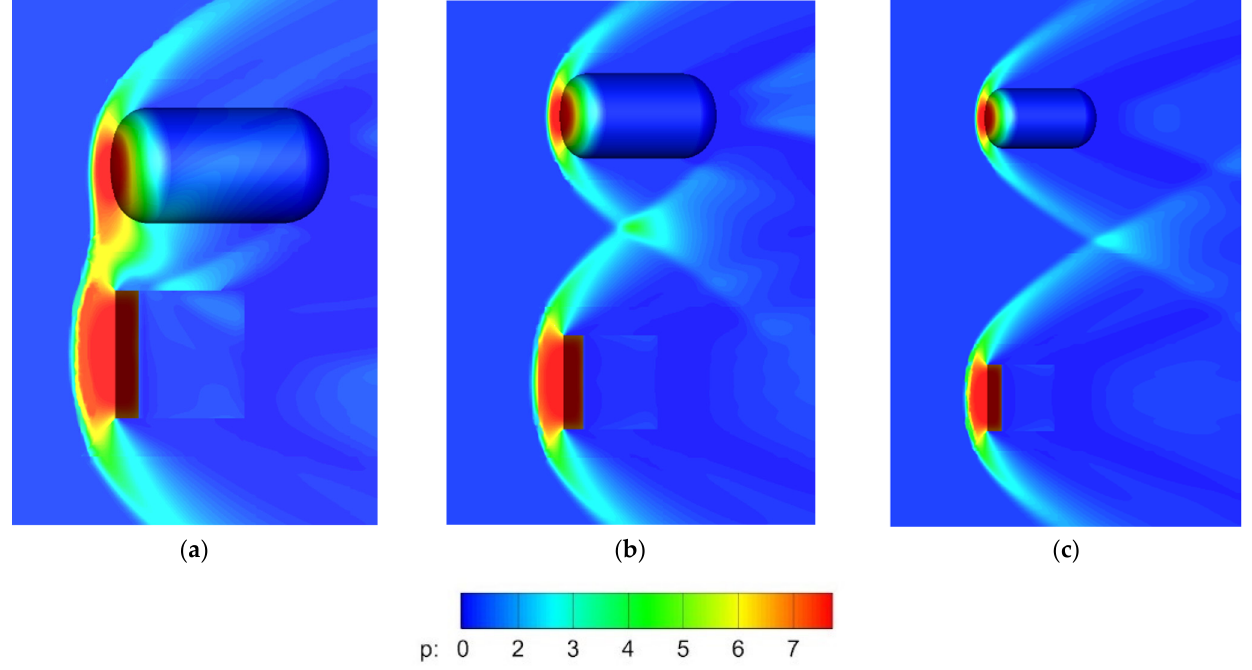
Figure 13. Dimensionless pressure contours of flow around propulsion cylinder bottle and cryostat placed paralleled with different Δ y: ( a ) Δ y = 1.5D; ( b ) Δ y = 3D; ( c ) Δ y = 4.5D.